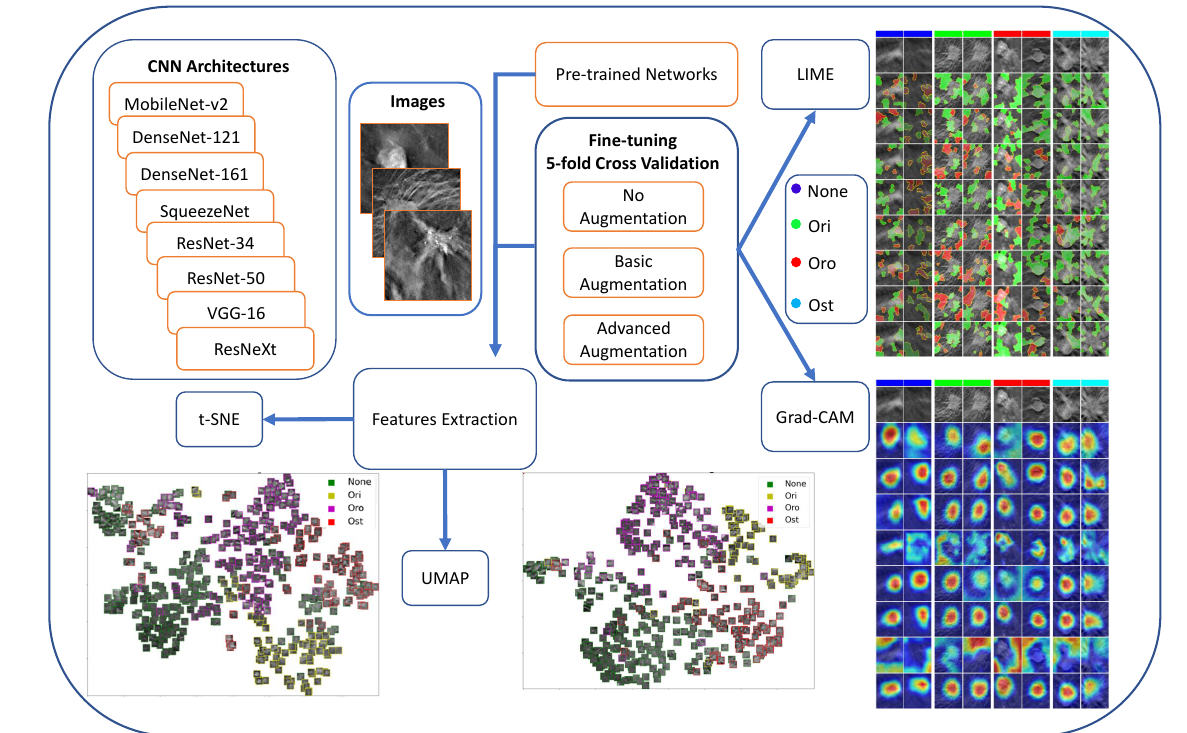
Figure 5. The overall flow diagram of the experiments. The experimental setup starts by fine-tuning the considered pretrained networks with three different datasets, i.e., the original one and two datasets obtained with two different data augmentation procedures. Thereafter, the features extracted by the feature maps of all versions of fine-tuned and pretrained networks were analyzed with both t-SNE and UMAP. Finally, Grad-CAM and LIME were applied to the RoI images.